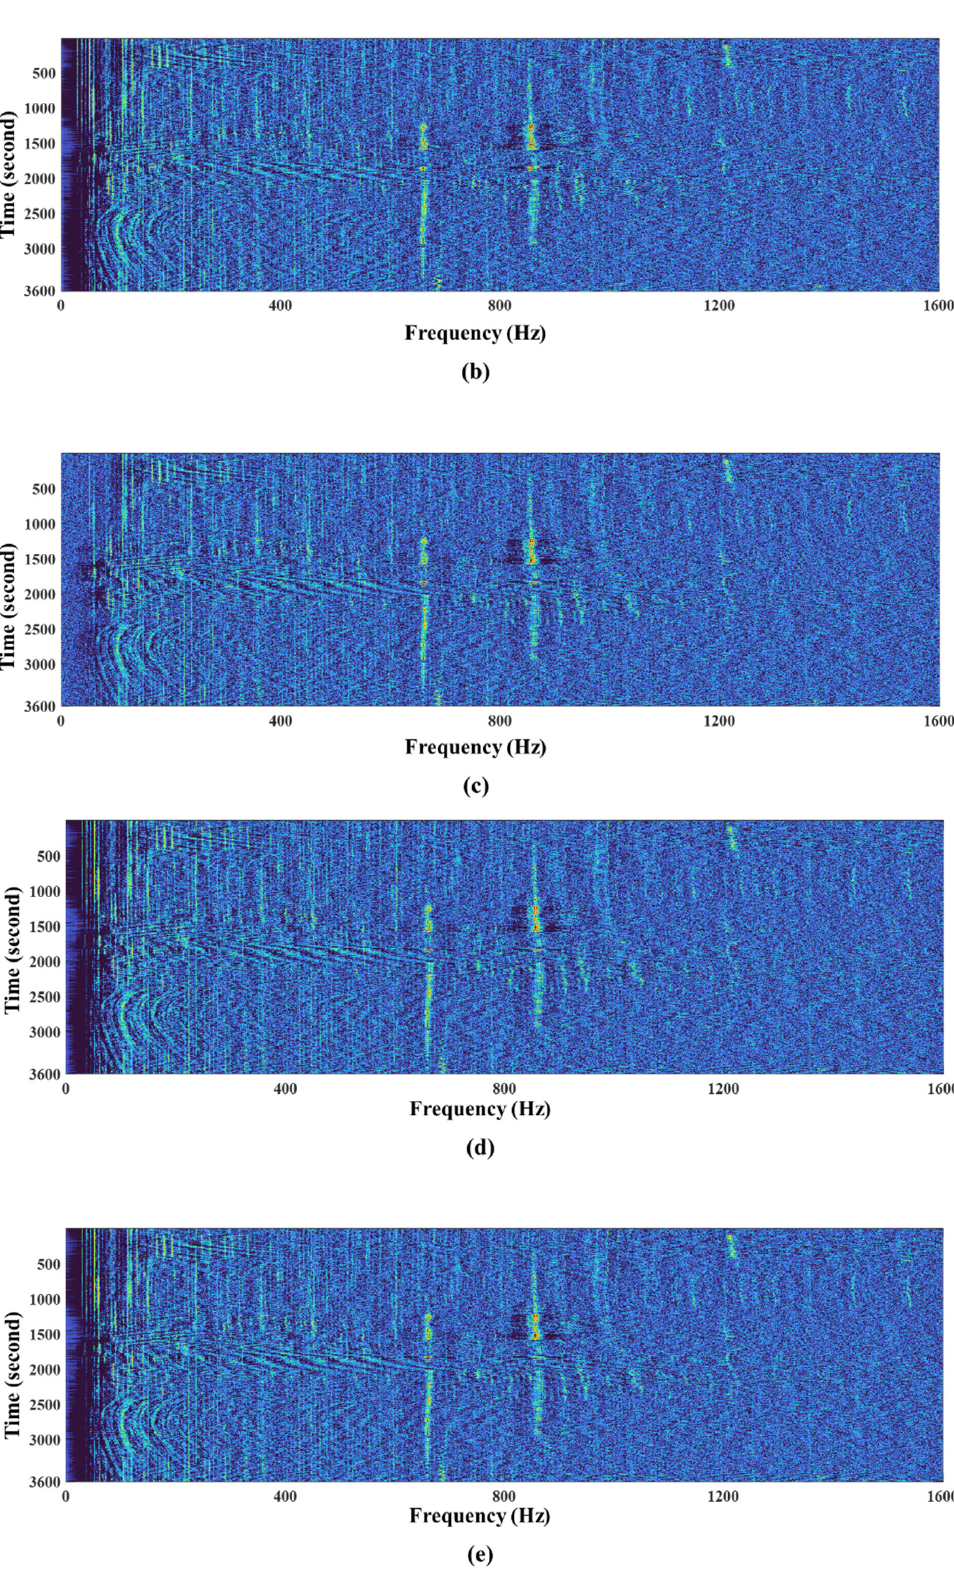
Figure 10. Illustration of LOFAR-grams of ( a ) an original sensor signal from sensor #6, ( b ) the reconstructed sensor signal by the proposed method, ( c ) the reconstructed sensor signal by the bit- depth reduction method, and ( d , e ) the reconstructed sensor signals by the lossy mode of SHORTEN with the maximum number of bits per sample was set between 9 and 10 bits, respectively.